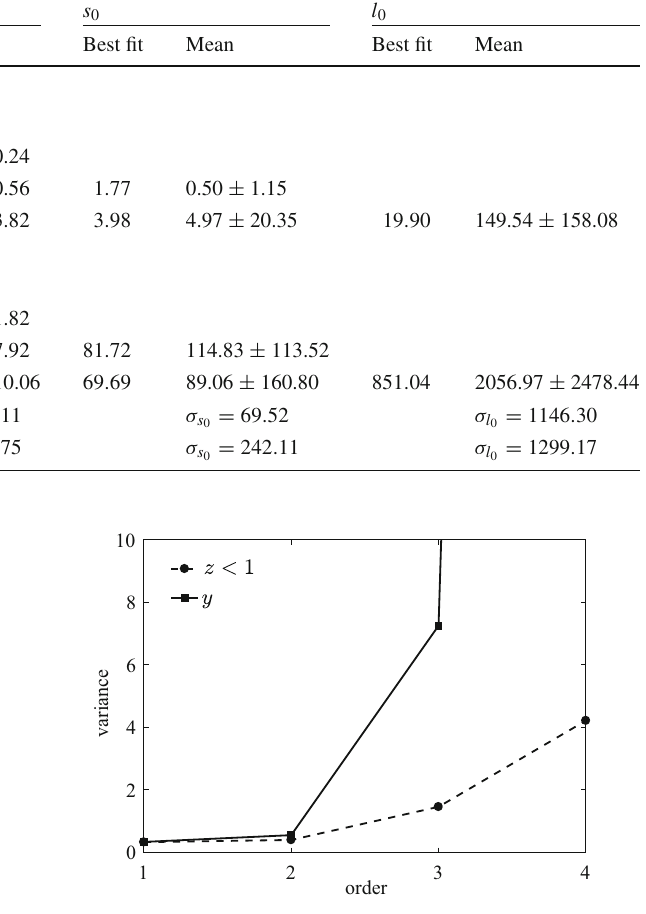
Fig. 4 Bias square in the z -redshift and y -redshift of the JLA com- pilation with different cosmographic series truncations at the basis of fiducial (cid:2) CDM model